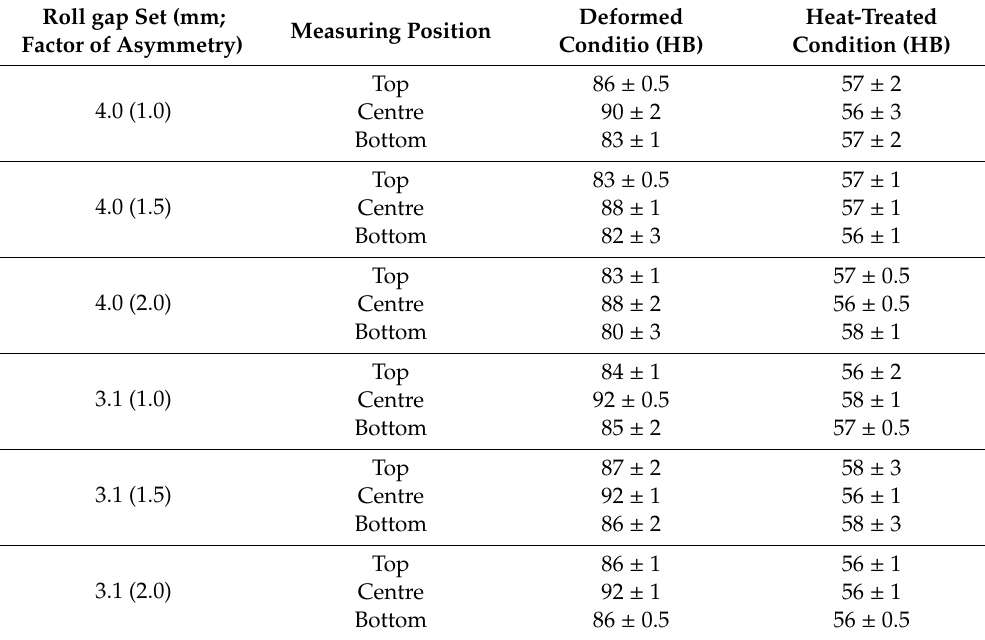
Table 4. Hardness for all rolling types in deformed and heat-treated